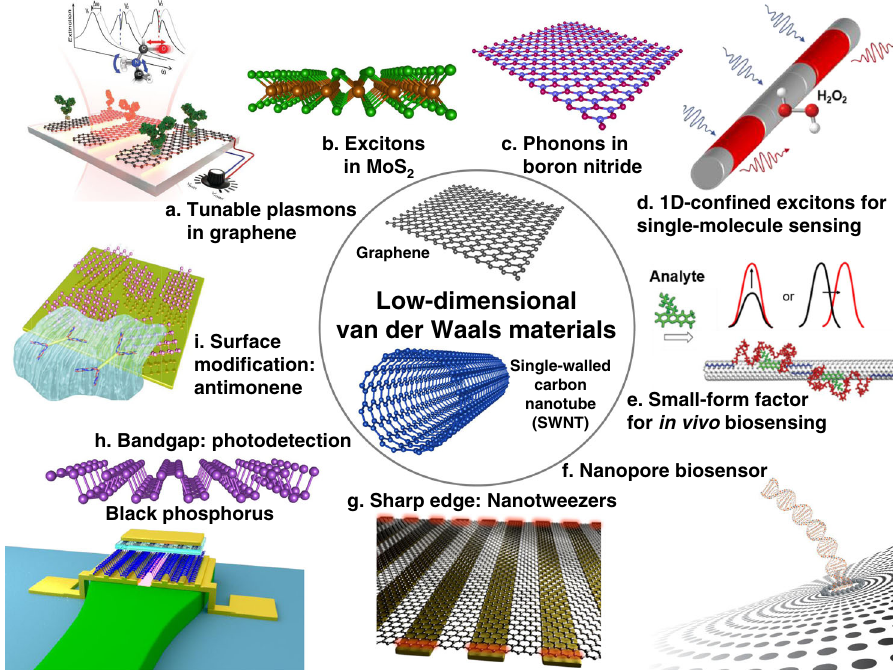
Fig. 2 Low-dimensional vdW materials for nanophotonic sensing applications. Polaritons in 2D vdW materials can offer novel sensing modalities. a Plasmons in graphene (Adapted with permission from ref. 26 ). b Excitons in MoS 2 . c Phonons in boron nitride. 1D vdW materials (SWNT) have been used for ( d ), exciton-based single-molecule detection (adapted with permission from ref. 27 ) and ( e ) in vivo biosensing (adapted with permission from ref. 28 ). vdW materials can also be utilized to construct. f Single-molecule nanopore sensor. g High-gradient- fi eld dielectrophoretic nanotweezers. h On-chip photodetector, and ( i ) high-af fi nity surfaces for speci fi c analytes (adapted with permission from ref. 31